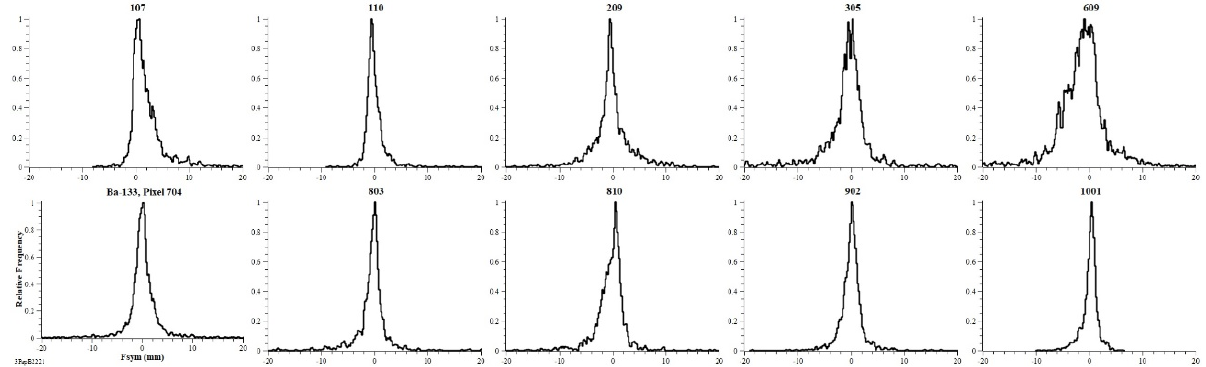
Figure 13. Fsym spectra from Ba-133 data regarding the selected decuple of pixels of the crystal-array with the best charge- symmetry response. Spectra are shown, from top-left to bottom-right, in ascending RRCC crystal-pixel order. Common axes titles and plot descriptions are reported only once in the bottom-left frame for better clarity. The selection criterion, based on Euclidian distances from origin in the plane (average, standard deviation), founded the best decuple of zero-centered spectra made by pixels 107, 110, 209, 305, 609, 704, 803, 810, 902, and 1001 whose distance values from origin ranged from 0.40- to 1.03-mm.